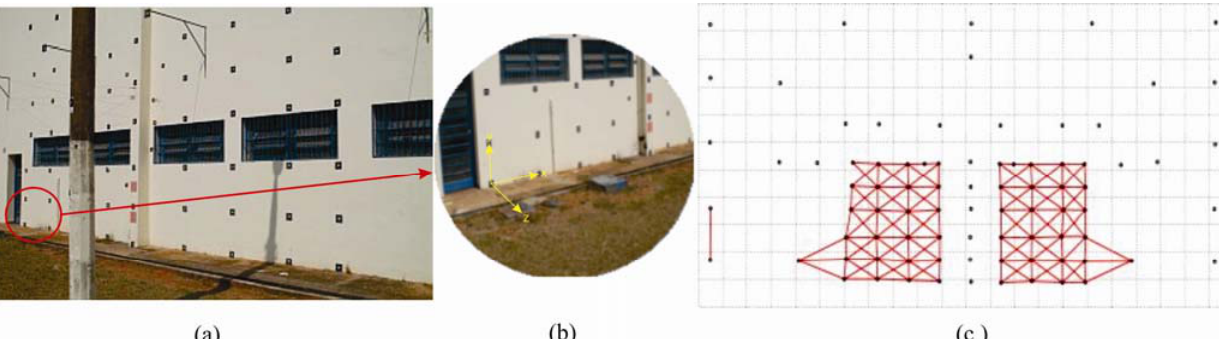
Figure 3. ( a ) Image of the calibration field; ( b ) origin of the arbitrary object reference system; and ( c ) existing targets and distances directly measured with a precision calliper for quality